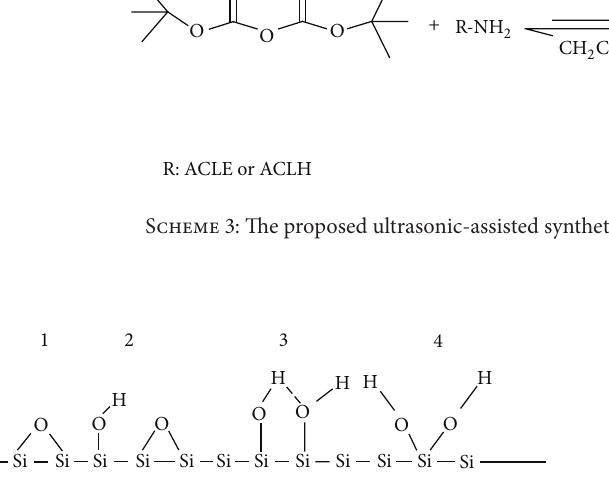
Figure 2: The structure of silicon dioxide surface (note: 1: silicon oxygen group; 2: isolated hydroxyl group; 3: adjacent hydroxyl group; 4: double hydroxyl